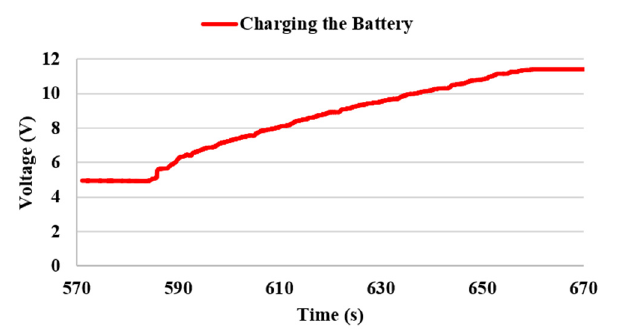
Figure 18. Experimental charging of electric vehicle battery in 90 s; Excel spreadsheet is extracted from Analog Discovery.